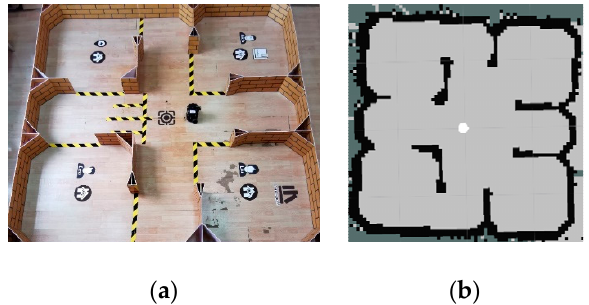
Figure 15. The experimental environment we built: ( a ) the real experimental scenario; ( b ) the corresponding environment map built by TurtleBot3 in Gmapping algorithm.